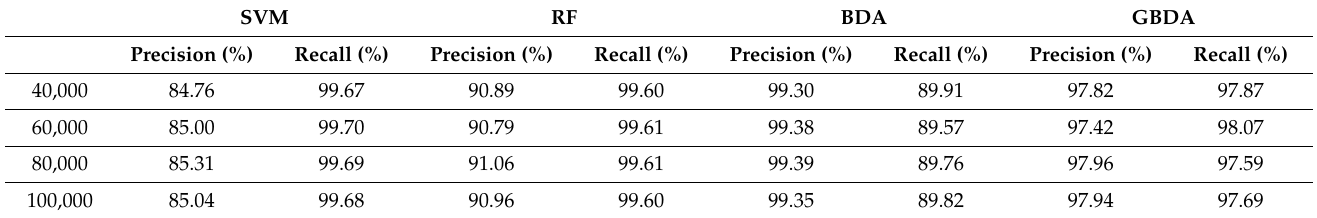
Table 3. Precision and recall of impervious surfaces of GF-2 remote sensing images.